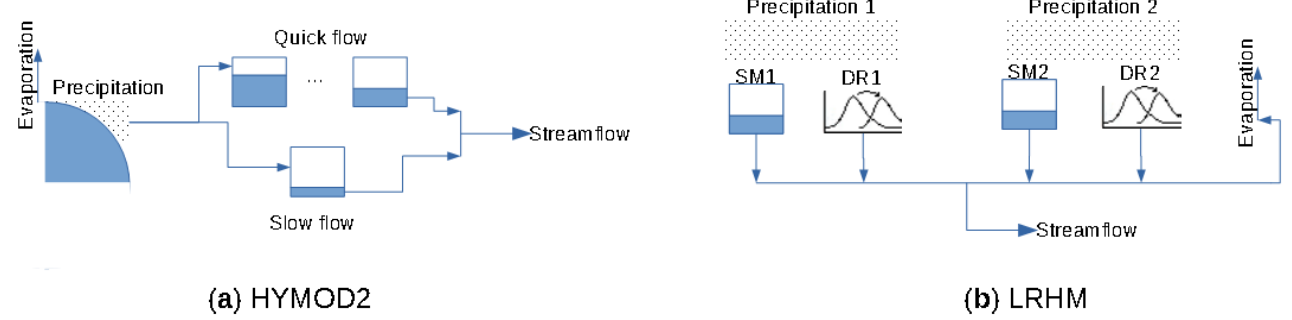
Figure 1. Schematic diagrams of HYMOD2 ( a ) and LRHM ( b ), SM1/2 soil moisture 1/2, DR1/2 direct runoff